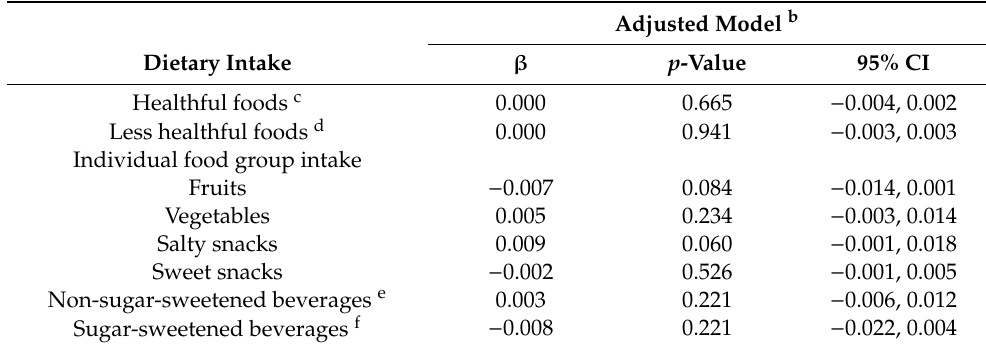
Table 4. Multiple linear regression predicting Stroop ratio a by intake of food and beverage group servings in the FLEX study population ( n =